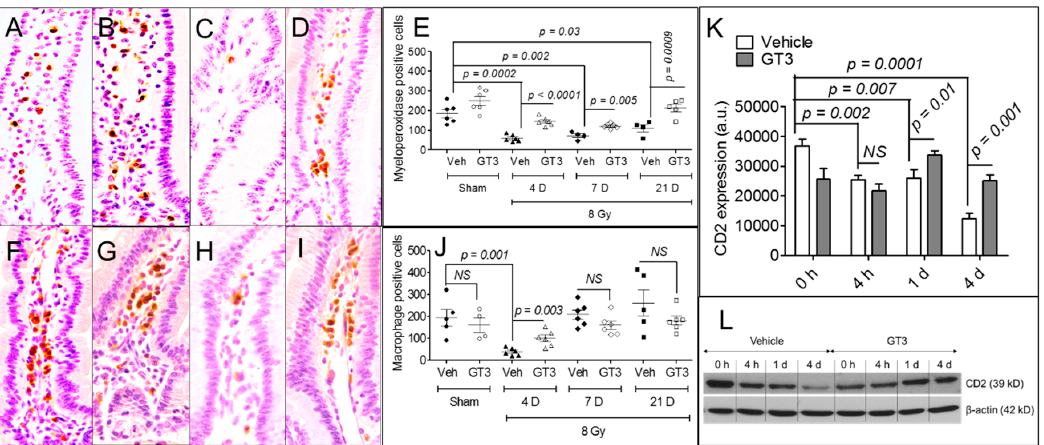
Figure 3. Effects of GT3 pretreatment on intestinal mesenchymal immune cells. A–D :